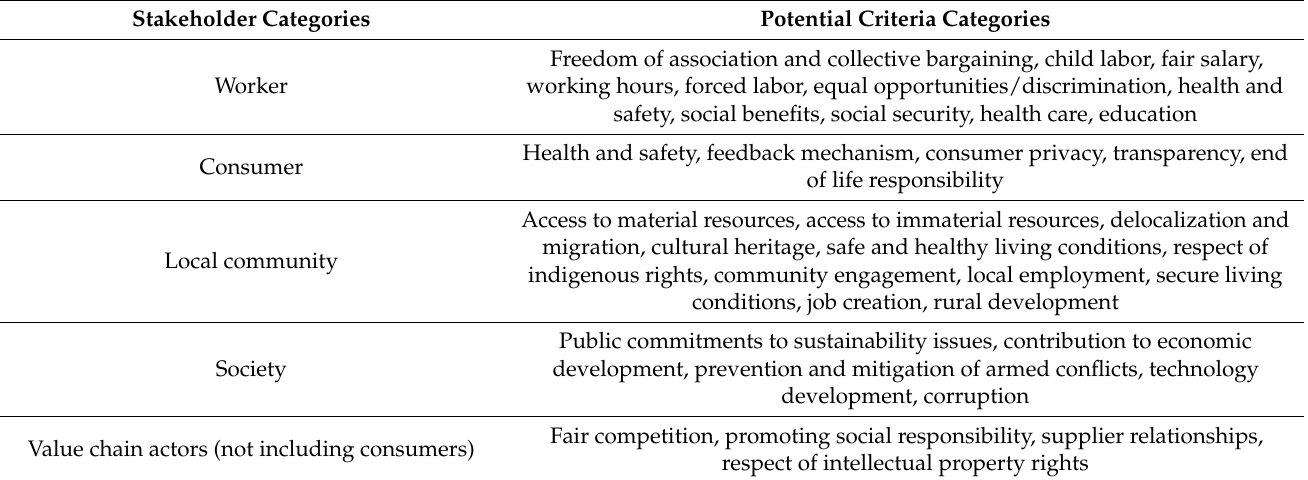
Table 1. Stakeholder categories and potential criteria categories adopted from Benoît et al. [19] and Ekener et al.